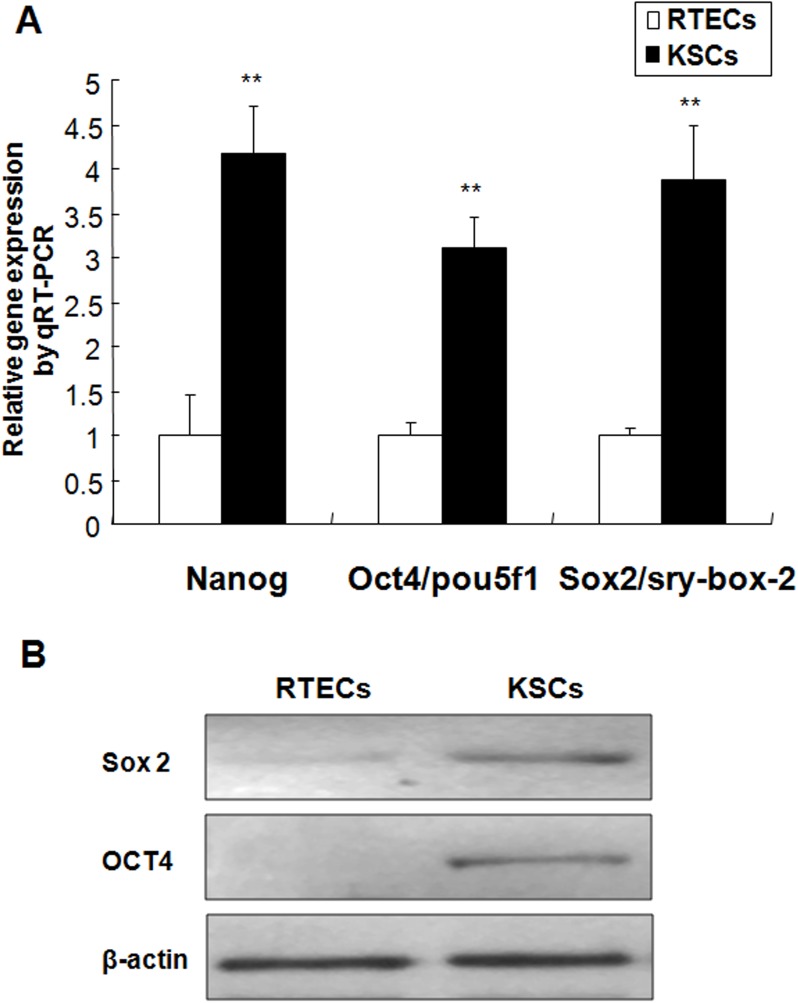
Embryonic stem (ES) cell marker expression in KSCs.(A) Nanog, Oct4/Pou5f1, and Sox2 gene expression in KSCs and RTECs. Data represents the mean fold change ± standard error of the mean (SEM) when comparing KSCs to RTECs. All values were normalized to Gapdh expression. (**P < 0.01). B: Western blot analysis of ES markers in KSCs and RTECs. β-actin was used as an internal control.